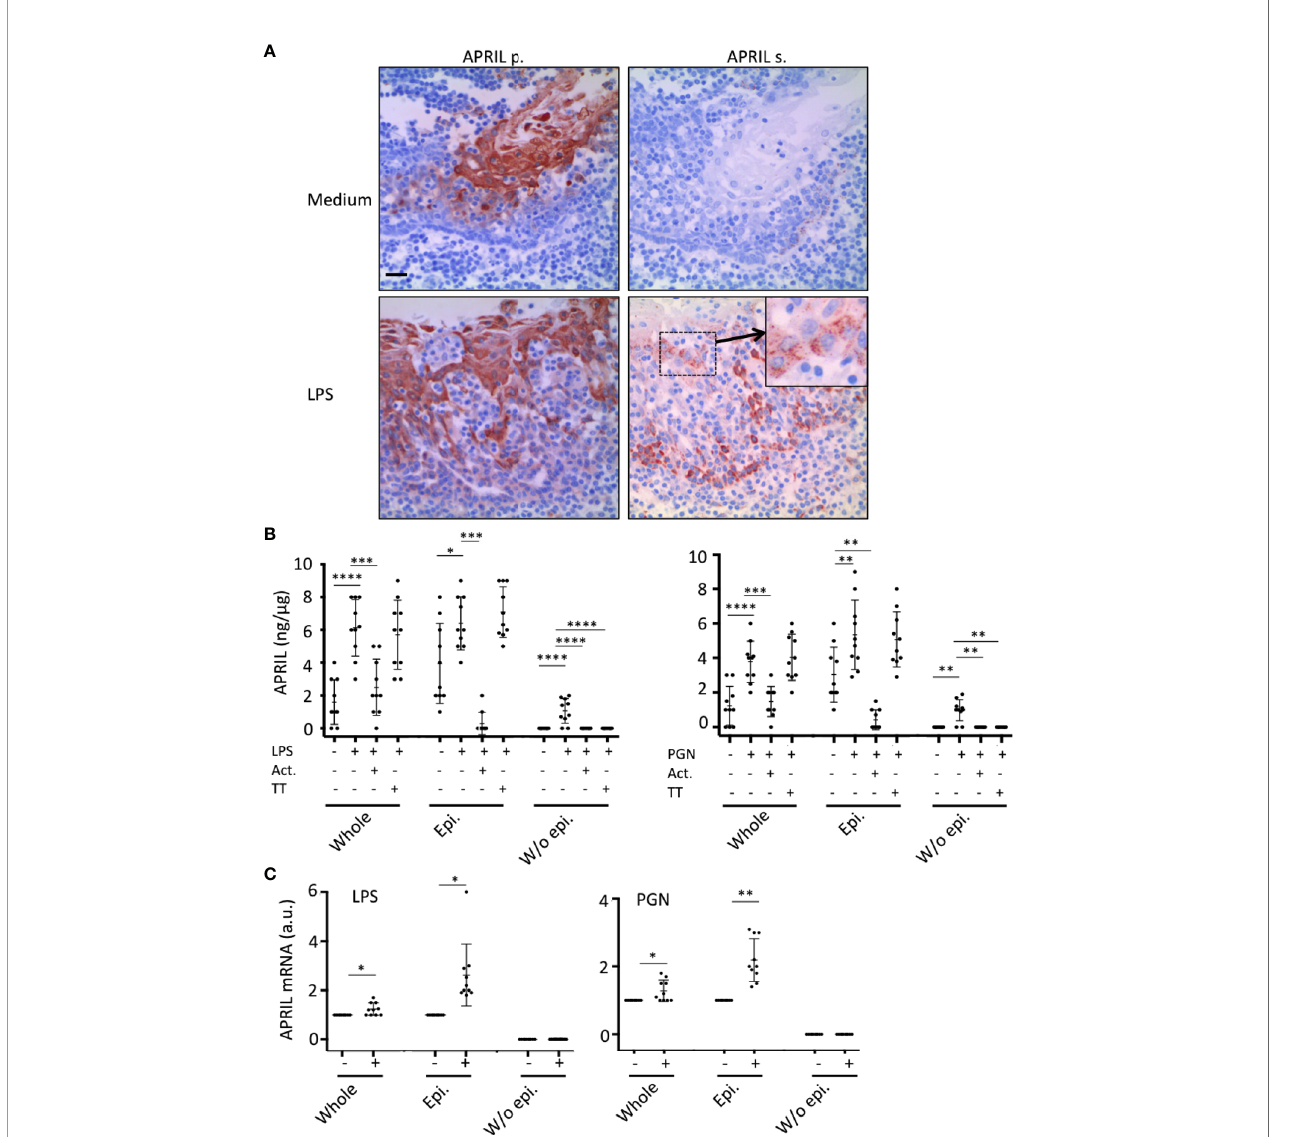
FIGURE 4 | Tonsil epithelium secretes APRIL in the parenchyma upon TLR stimulation. (A) Serial sections of medium- and LPS-stimulated tonsils were stained for APRIL production and secreted APRIL. Insert shows a high magni fi cation of a cluster of apical epithelial cells positive for secreted APRIL. A crypt epithelium is shown. Scale bar = 20 µm. (B) APRIL was quanti fi ed by ELISA from the indicated parts of unstimulated, LPS-, and PGN-stimulated tonsils. Actinomycin D (Act.) and Tetanus toxin (TT) were used to block transcription and exocytosis, respectively. A paired parametric ANOVA test was performed. (C) APRIL mRNA was quanti fi ed by qRT-PCR in the indicated part of unstimulated and LPS/PGN-stimulated tonsils. Results are representative of 10 tonsillectomies. Non-in fl amed tonsils removed for snoring problems were used. Means +/ − SD are shown. A paired non-parametric t test was performed. *p < 0.05, **p < 0.01, ***p < 0.001, ****p <